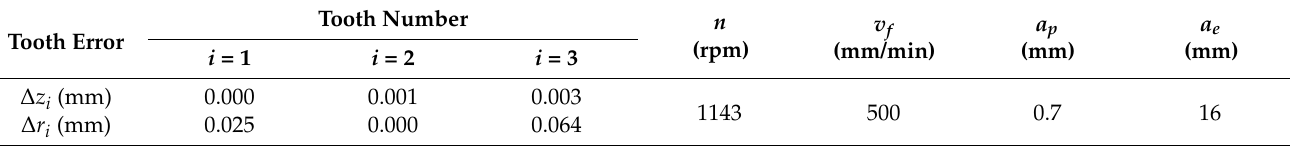
Table 2. Experiment scheme